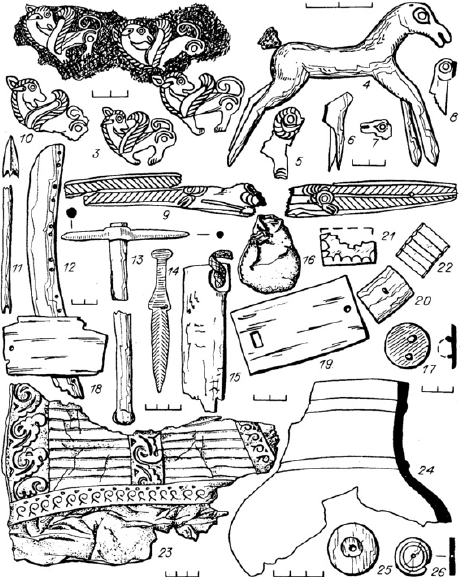
Figure 5. Contents of kurgan 22, Yustyd XII. (Adapted from Kubarev 1991, PL LI). Kubarev identifies 4 as a volumetric undefined animal figure with plug-in leather tail (he does not distinguish the animal as either deer or horse) and identifies 5–8 as remnants of figures of horses and deer, without specifying which is which. Plan of burial is Figure 3 above.